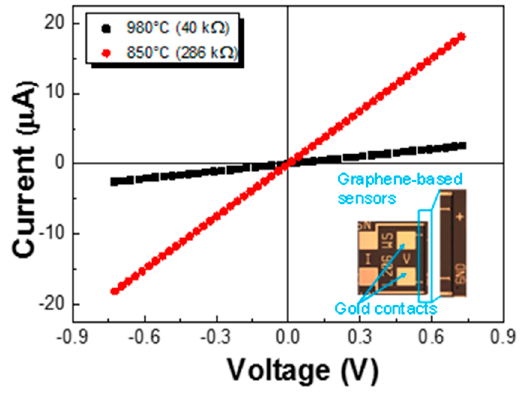
Figure 1. I-V characteristics of the graphene-based resistors reported in the